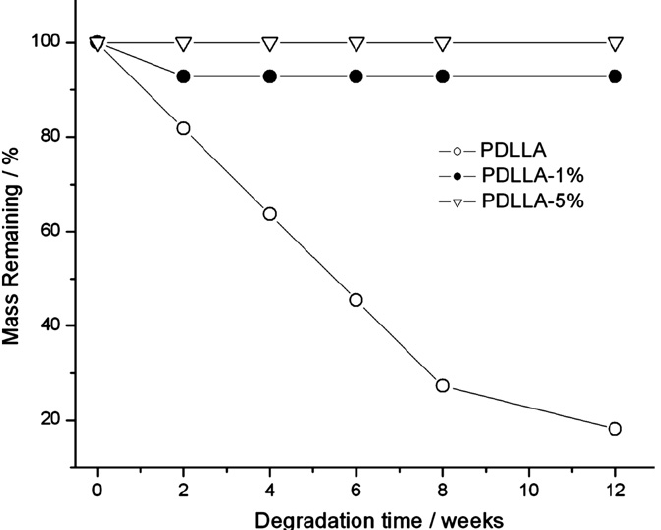
Figure 8. Residual mass of neat poly( D , L -lactide) (PDLLA), PDLLA with 1%, and PDLLA 5% of CNWs as a function of degradation time. Reproduced with permission from [178]. Copyright 2011